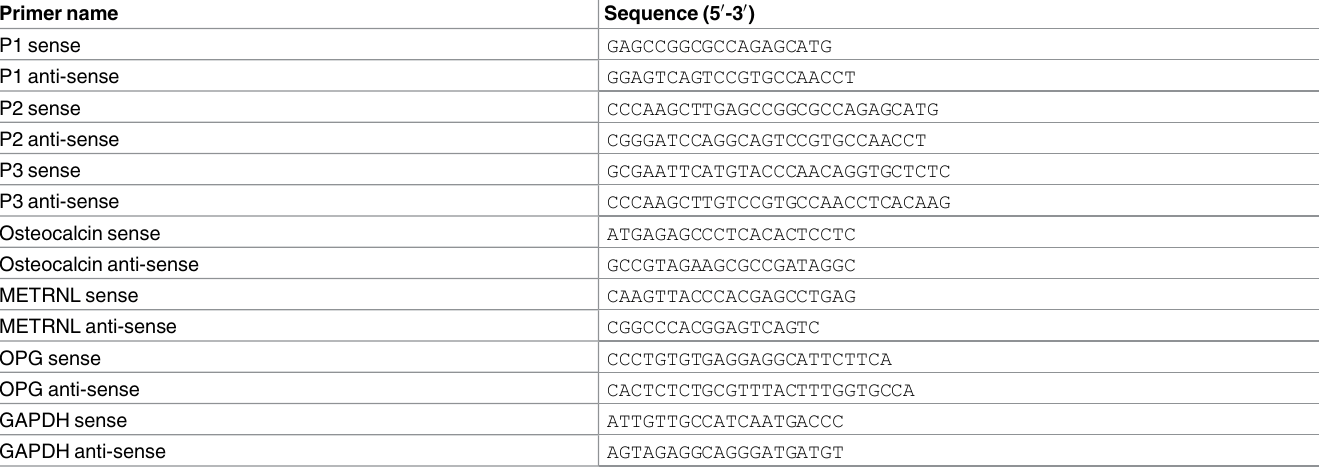
Table 1. Sequences of primers used for gene cloning and quantification of gene expression by quantitative real-time PCR. Primer